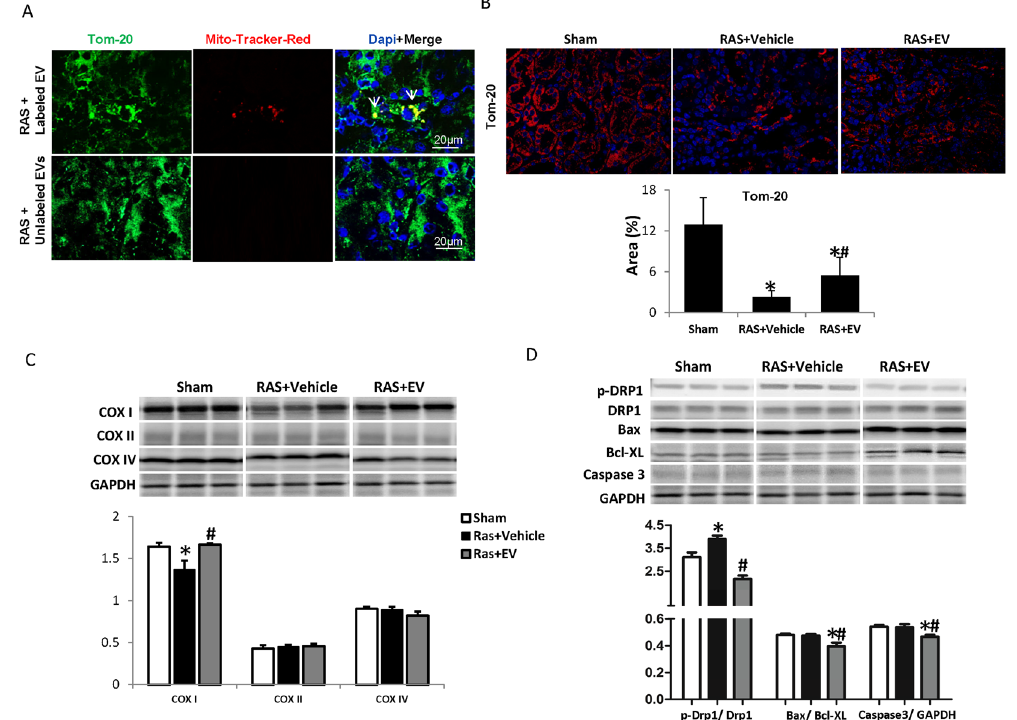
Figure 7. Mitochondrial regulation in the stenotic kidney (STK). ( A ) Representative images of Mito-Tracker- Red labeled EV (White arrows) in STK 2 weeks after delivery. Green shows endogenous mitochondria staining. ( B ) Tom-20 staining was used to assess renal mitochondrial density, which decreased in RAS STK and improved by EV. ( C ) RAS mice STK showed decrease of COXI expression, which was reversed by EV. No significant alterations were observed in COXII and COXIV. ( D ) The ratio of phosphorylated-Drp1/total Drp1 increased in STK, which was reversed by EV. There were no significant changes in caspase3, Bax/Bcl-XL ratio in STK, however, EV down-regulated both caspase3 and Bax/Bcl-XL ratio ( * P < 0.05 vs SHAM, # P < 0.05 vs RAS + Vehicle). The representative Western blots were cropped from the different parts of the same gel, and the full-length blots can be found in Supplementary info